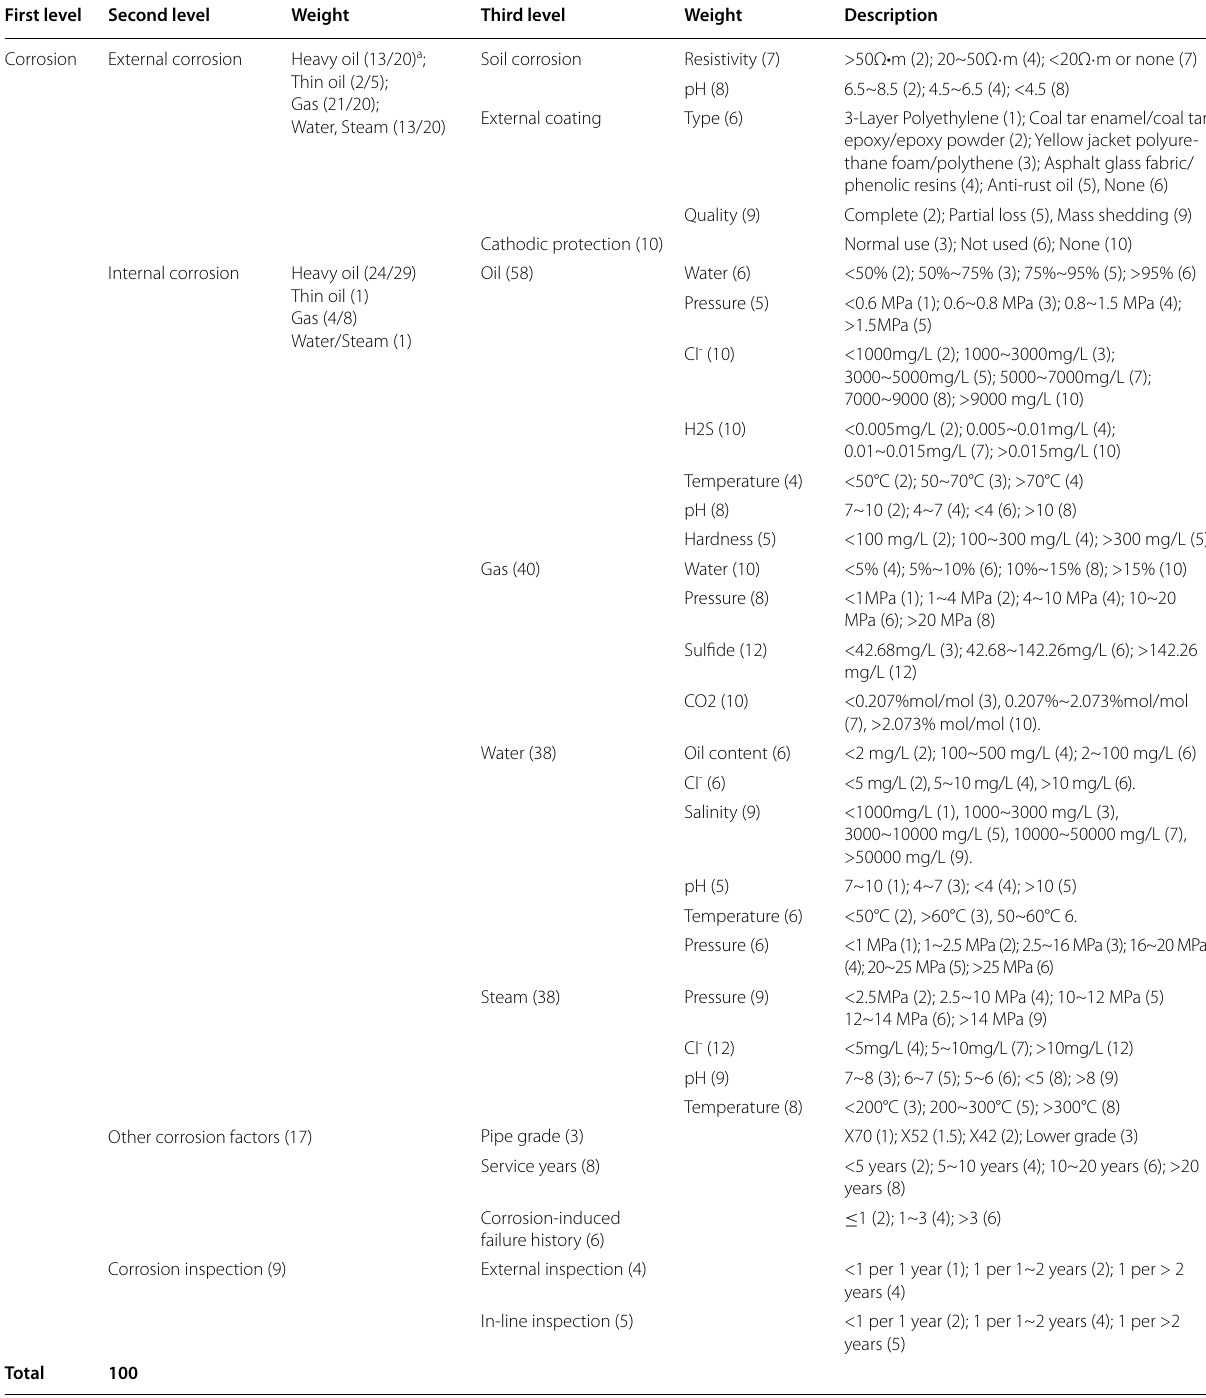
a For different media, the weight should be multiplied after the evaluation, e.g., it is necessary to multiply the weight 26/40 after evaluating the external corrosion of the heavy oil